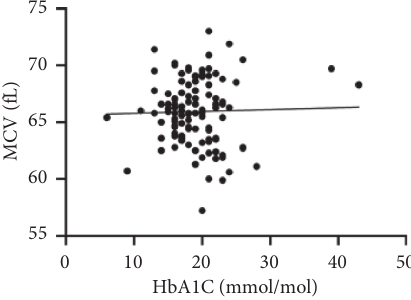
Figure 8: Relation between MCV and HbA1c ( r � 0.0007; p � 0 . 772).